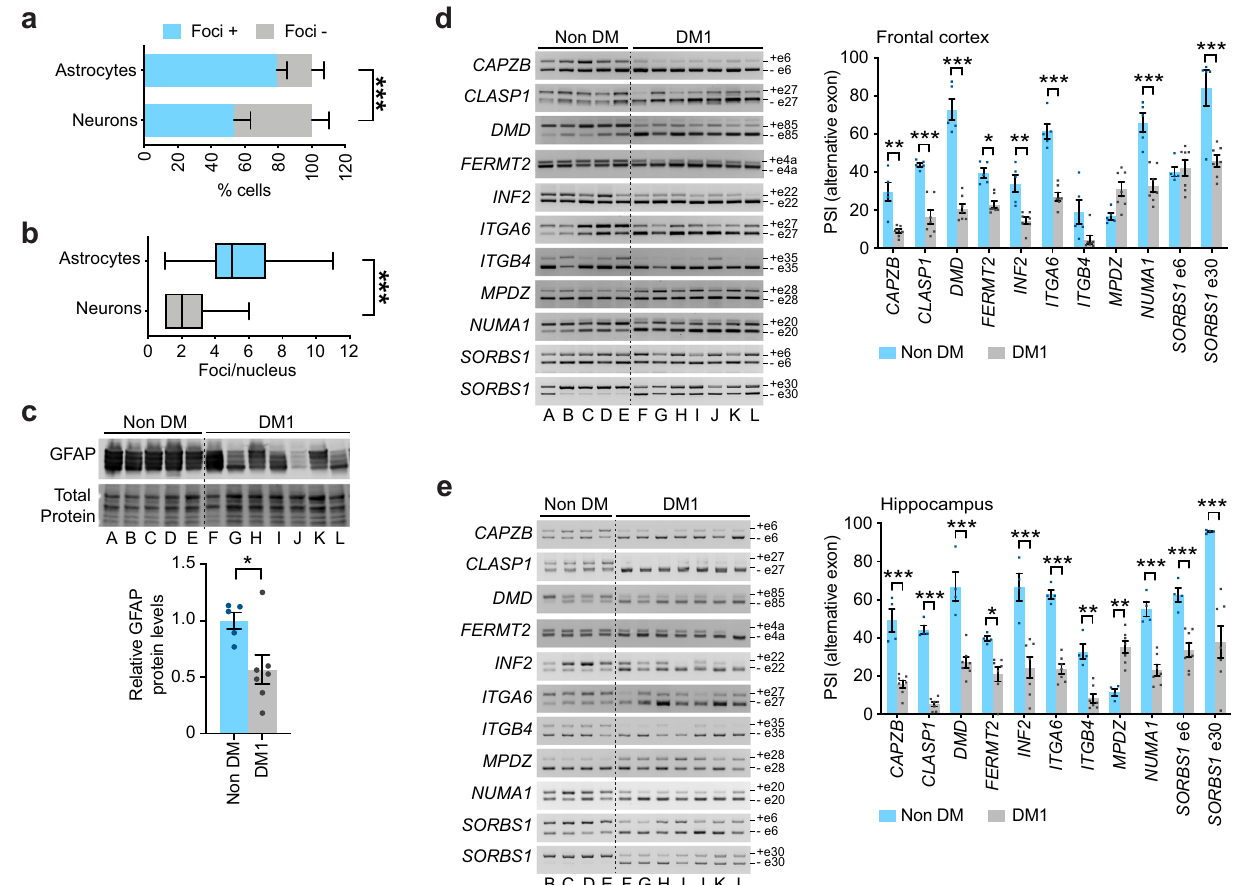
Fig. 9 Pronounced foci accumulation in astrocytes and splicing dysregulation of adhesion and cytoskeleton-related transcripts in human DM1 brains. a Percentage of GFAP-positive astrocytes and MAP-positive neurons exhibiting nuclear RNA foci in the frontal cortex of DM1 patients ( p < 0.0001, χ 2 test). Data are means ± SEM, N = 3 individuals, n = 152 astrocytes, n = 101 astrocytes. b Tukey whisker plots representing the number of foci per nucleus in human cortical astrocytes and neurons ( p < 0.0001, Two-tailed Mann – Whitney U test). The plots display the median and extend from the 25th percentile up to the 75th percentiles. The whiskers are drawn down to the 10th percentile, and up to the 90th percentile. N = 3 DM1 patients; n = 284, astrocytes; n = 202, neurons. c Western blot quanti fi cation of GFAP in tissue lysates prepared from post-mortem human frontal cortex. Representative stain-free protein bands are shown to illustrate total protein loading. Data are means ± SEM. n = 5, non-DM; n = 7, DM1 ( p = 0.0480, Two-tailed Mann – Whitnet